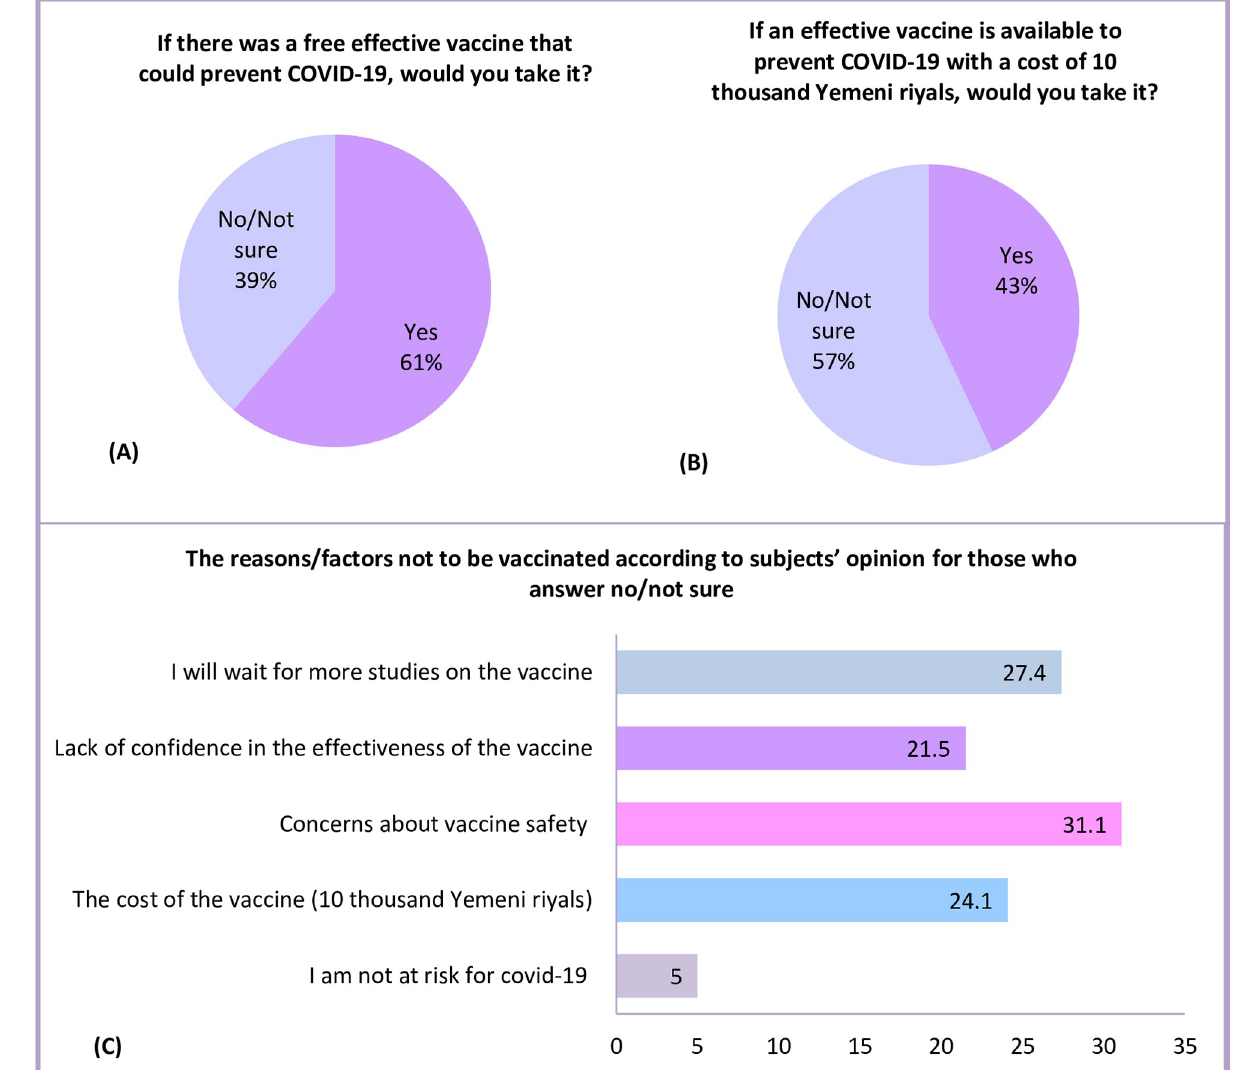
Fig 1. A-C Willingness to vaccinate and the barriers that are hindering Yemeni people from vaccination (n =